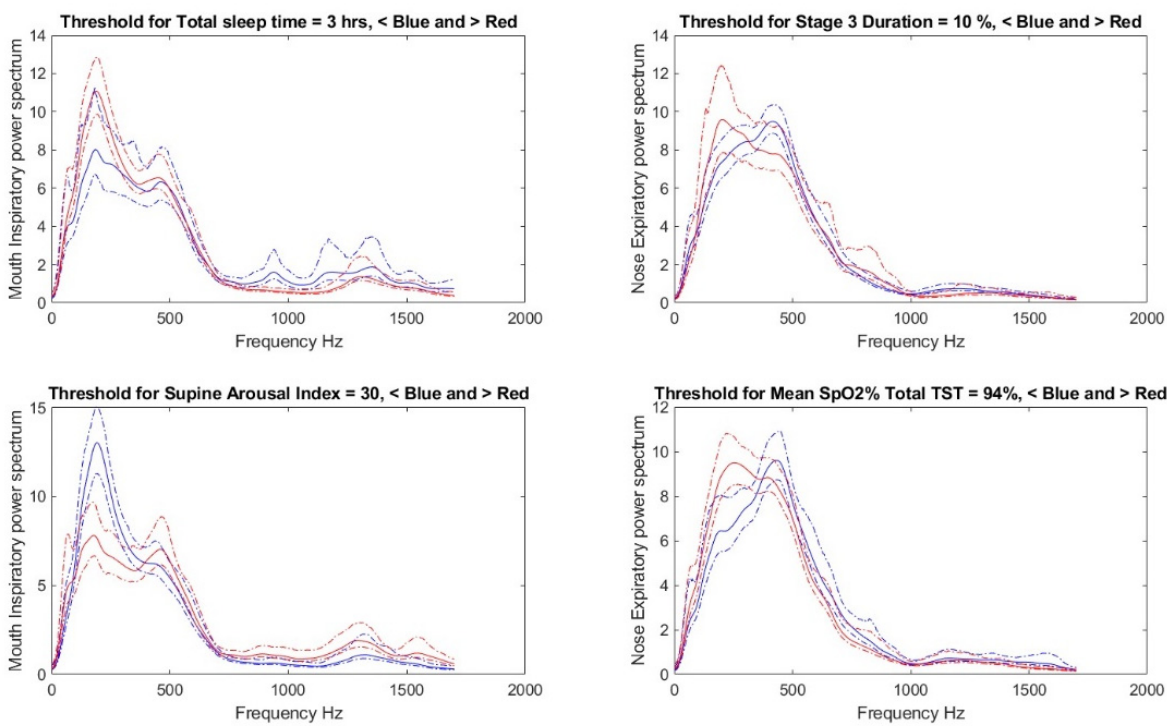
Figure 6. The average power spectrum of the signal recorded from mouth inspiration. Dotted lines represent the 95% confidence interval. Red and blue color curves represent the groups with more and less than the threshold, respectively.